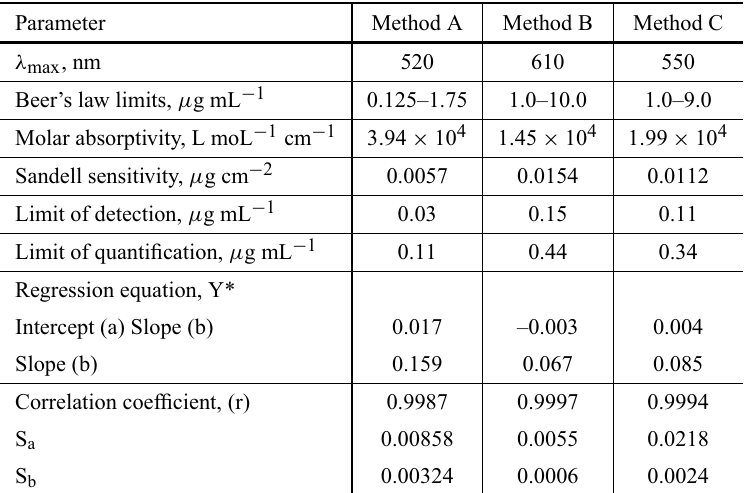
Quantification and regression characteristics of spectrophotometric